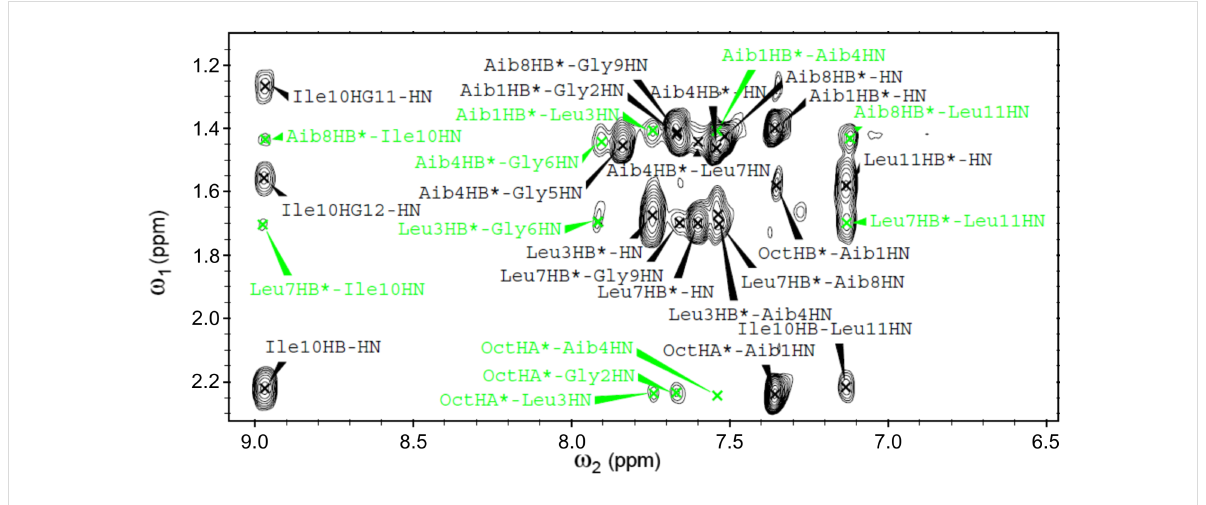
Figure 7: Fingerprint region of the H/H-ROESY spectrum of ψ [CS-NH] 9 (400 MHz, 1 mM in CD 3 CN solution, 298 K). The C β H i → NH i +2 , C β H i → NH i +3 , and C β H i → NH i +4 cross peaks are highlighted in color.